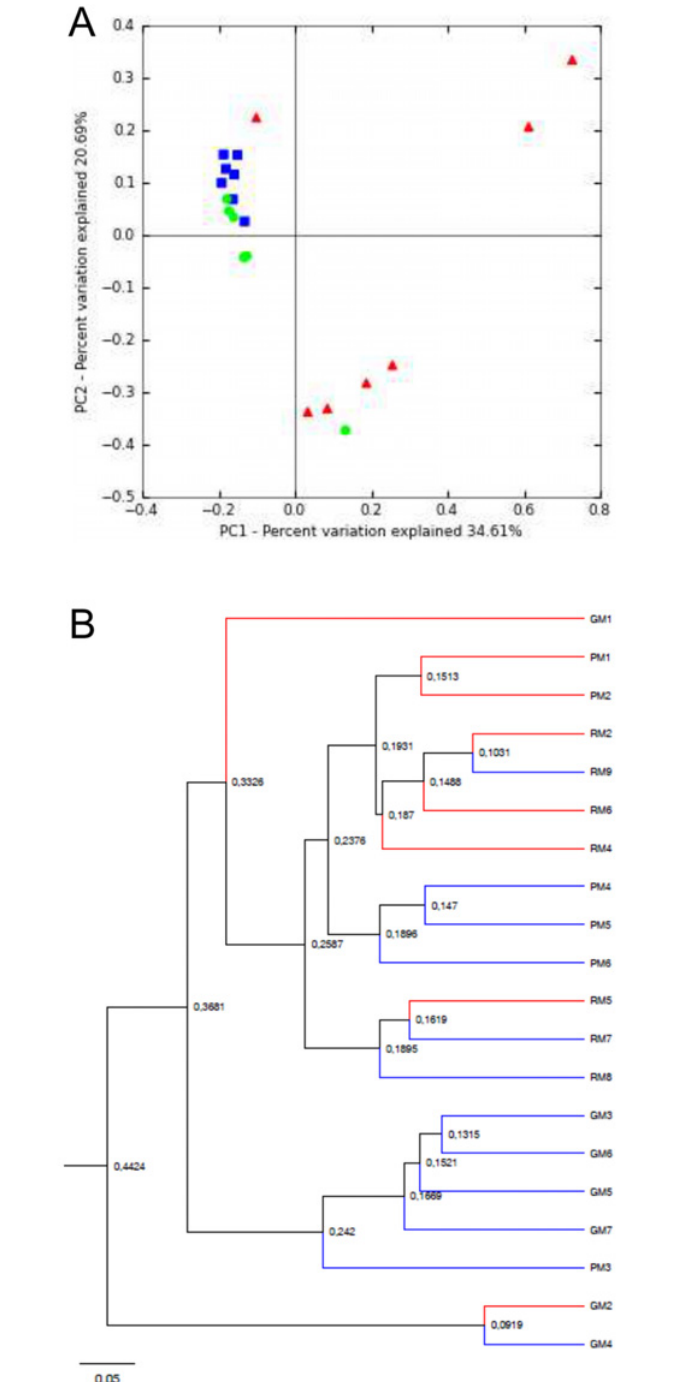
Fig 2. Analysis of microbiota data for the 20 CF sputum samples based on non-phylogenetic distances. A) Principal coordinate analysis of microbial community structure per patient using Bray Curtis distances. PC1 and PC2 represented 55.3% of the variability. Red triangles: patient GM ’ s samples. Green circles: patient PM ’ s samples. Blue squares: patient RM ’ s samples. B) UPGMA clustering of samples using Bray Curtis distances. BT samples are represented by red branches and AT samples by blue branches. The scale bar represents a 5% sequence divergence.